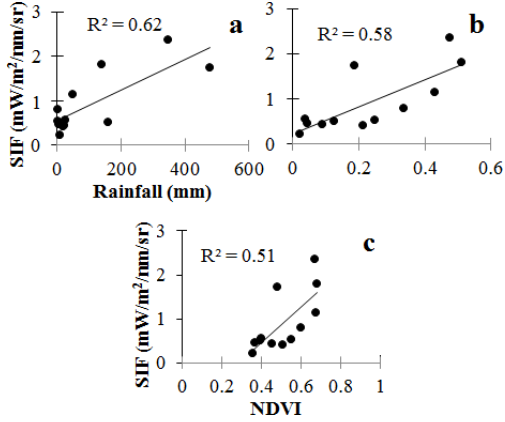
Figure 5. GOME-2 SIF relationship with rainfall (a), GPP (b) and NDVI (c) for TDD